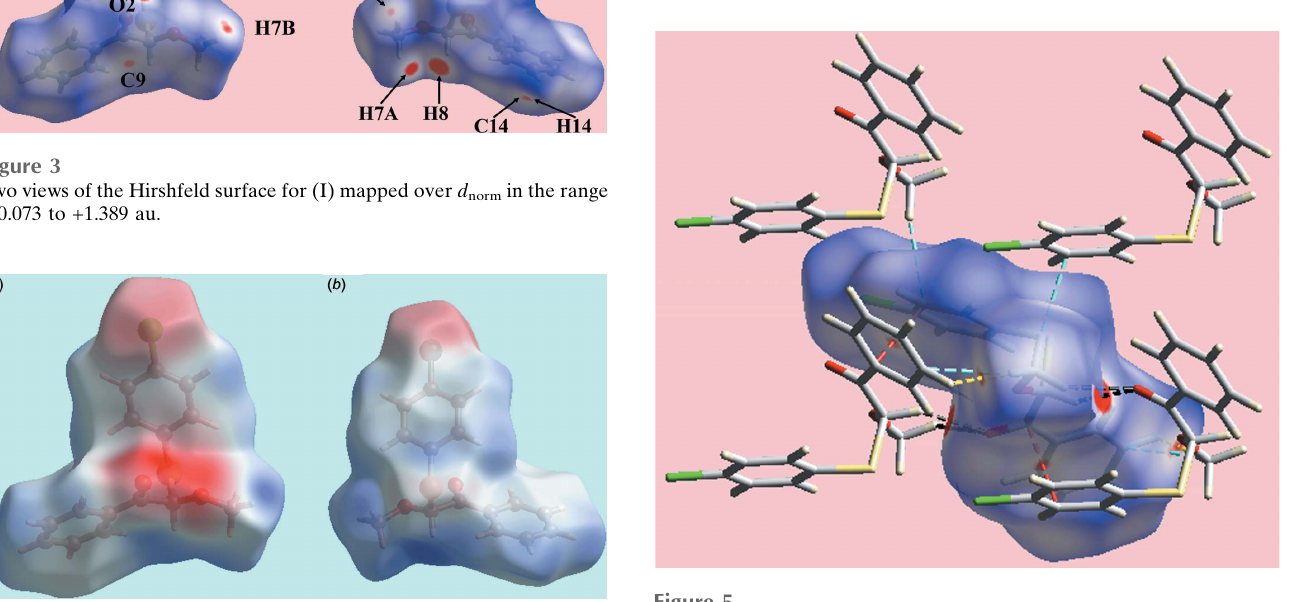
Figure 5 Aview of the Hirshfeld surface mapped over d norm in the range (cid:5) 0.073 to +1.389 au highlighting intermolecular C—H (cid:3)(cid:3)(cid:3) O, C (cid:3)(cid:3)(cid:3) C, H (cid:3)(cid:3)(cid:3) H and C (cid:3)(cid:3)(cid:3) H/H (cid:3)(cid:3)(cid:3) C contacts by black, red, yellow and sky-blue dashed lines, respectively.